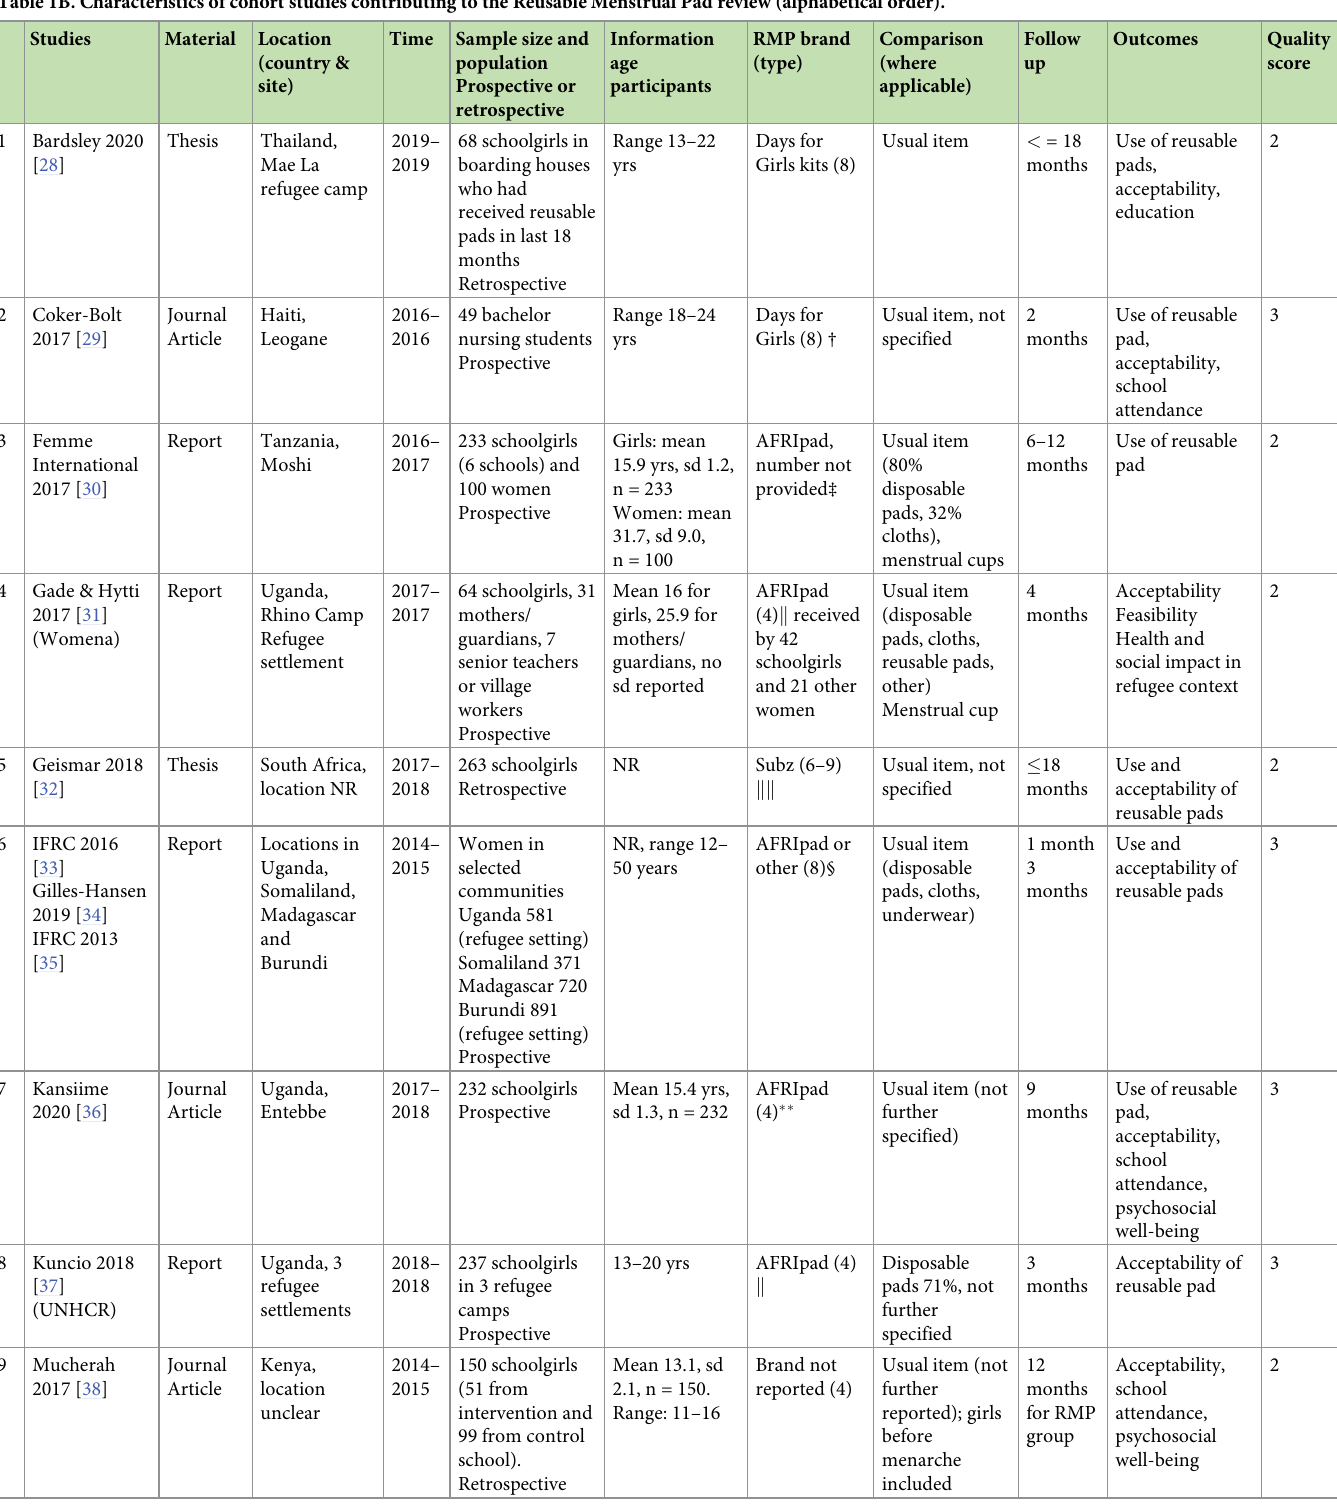
Table 1B. Characteristics of cohort studies contributing to the Reusable Menstrual Pad review (alphabetical order).